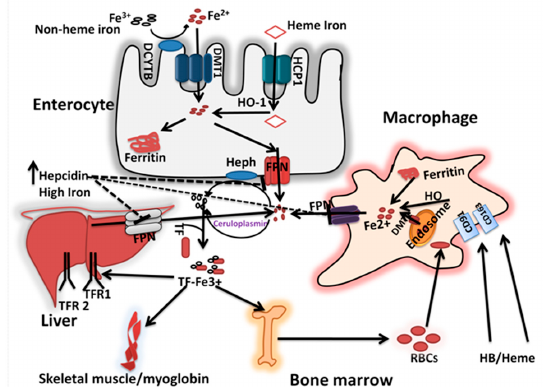
Figure 1. Iron absorption and homeostasis: The dietary non-heme iron is first reduced to ferrous form by Dcytb and is taken up via DMT1 at the apical surface of the enterocytes. Dietary heme iron is taken up via HCP 1 and degraded inside the cell by HO-1 to release iron. Within the enterocyte, the iron is either stored in ferritin or transported to the circulation. At the basolateral membrane, the ferrous iron transported via FPN1, coupled with its oxidation by HEPH. The senescent erythrocytes are phagocytosed by macrophages via CD91/CD163, and are degraded in lysosomal compartments to release iron, which then are excreted into cytosol via DMT1. The iron is then transported out of the macrophage via FPN1 possibly coupled with ceruloplasmin dependent iron oxidation. In the blood, ferric iron is transported bound to Tf, and delivered to the target tissues, the bone marrow, liver and muscle via TfR-dependent mediated endocytosis pathway. When the iron stores are adequate, the hepcidin released from the liver into the blood, which in turn inhibits the FPN1 mediated iron release from intestinal cells and other tissues involved in iron